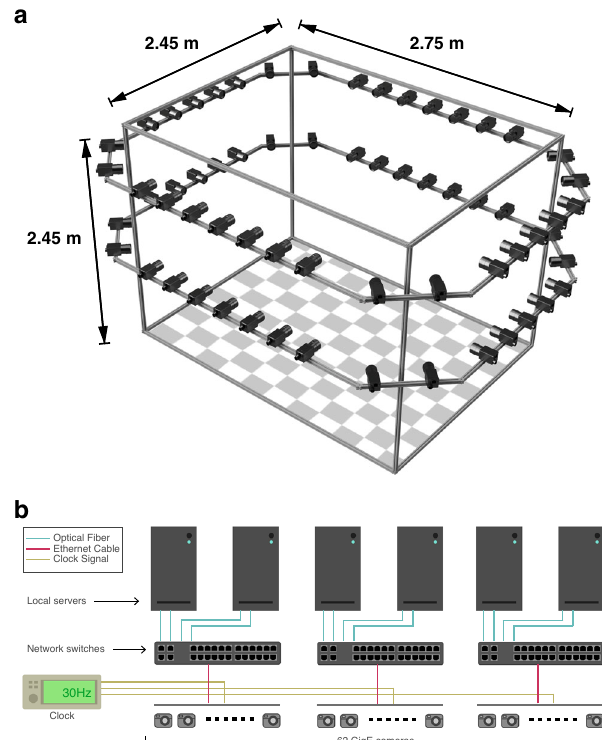
Fig. 10 System architecture. a OpenMonkeyStudio integrates 62 cameras into a large space (2.45 × 2.45 × 2.75 m) that allows unconstrained movement of macaques. These cameras face at the center of space, which is ideal for view augmentation and reconstruction. b System con fi guration of distributed image acquisition. Sixty-two cameras are connected to the local servers through 10 Gb network switches, and six local servers are controlled by a global server. The cameras are triggered by the external clock, which allows